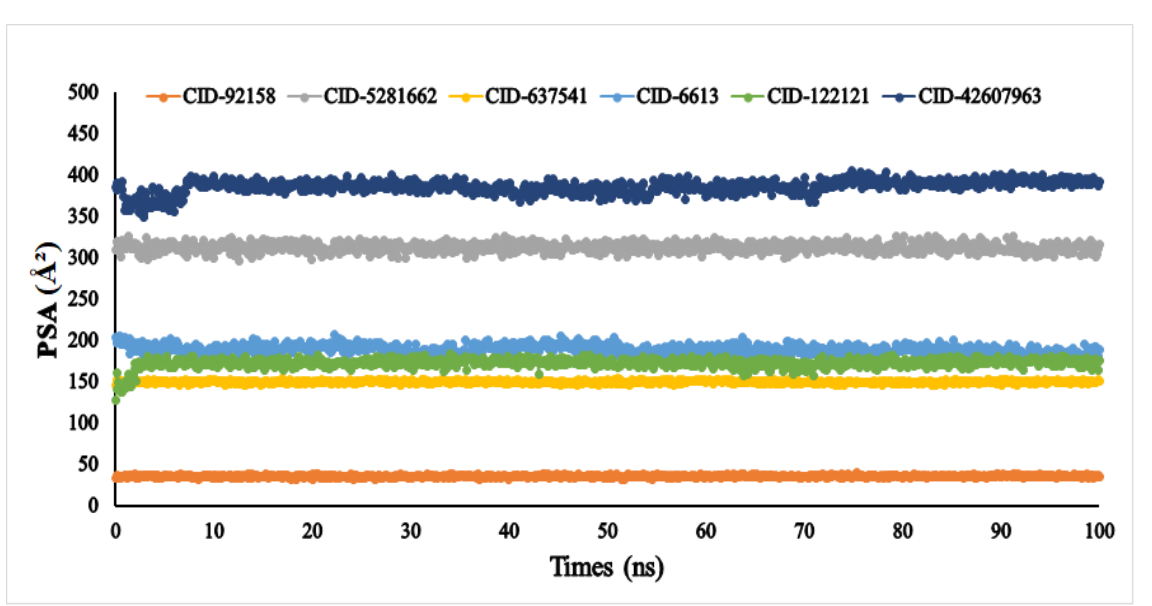
Figure 9. The solvent accessible surface area (SASA) of the selected six compounds, viz., lupenone (CID: 92158), swertianolin (CID: 5281662), m -coumaric acid (CID: 637541), pantothenic acid (CID: 6613), phytosphingosine (CID: 122121), and 8- C -glucopyranosyleriodictylol (CID: 42607963), in association with the targeted protein α -glucosidase (PDB ID: 3A4A) are shown by specific colour.